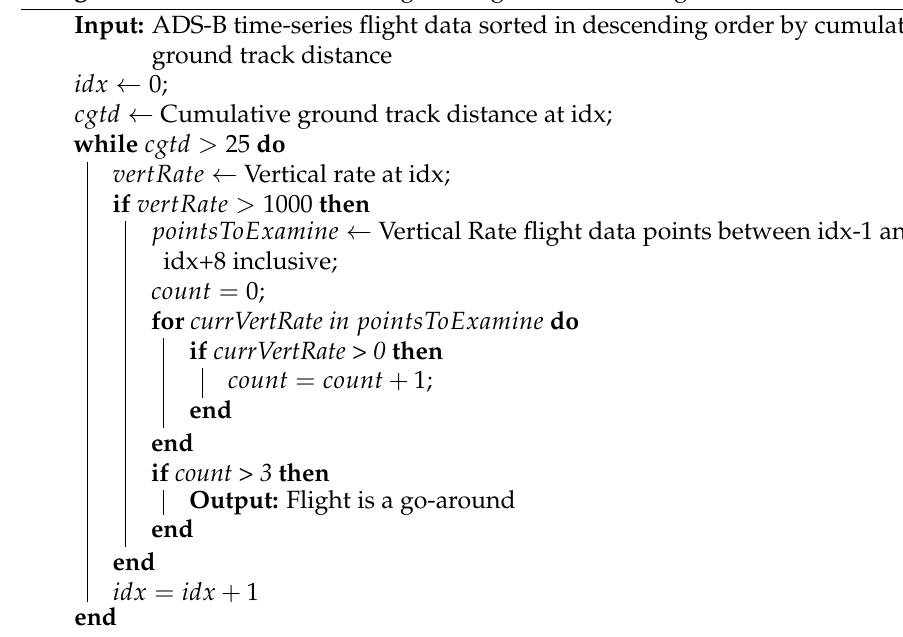
Algorithm 1: Detects whether a given flight conducted a